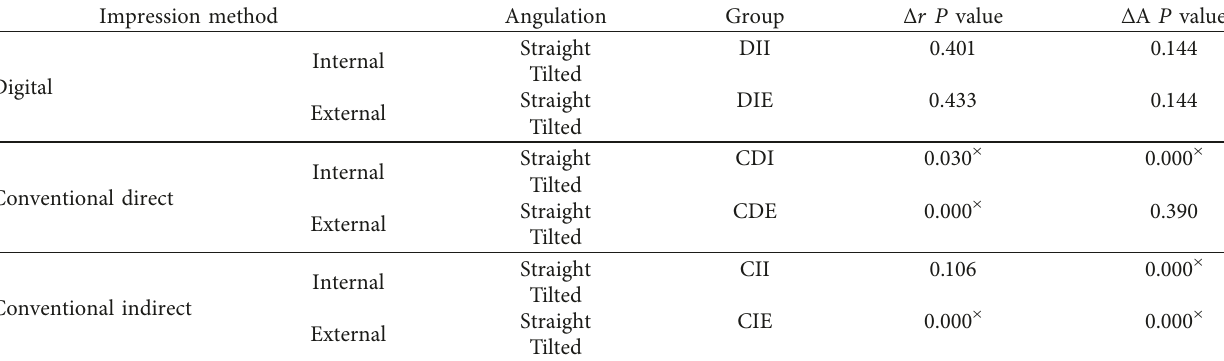
Table 5: The effect of implant angulation by comparing inaccuracy values for each group at the connection type and impression technique. Impression